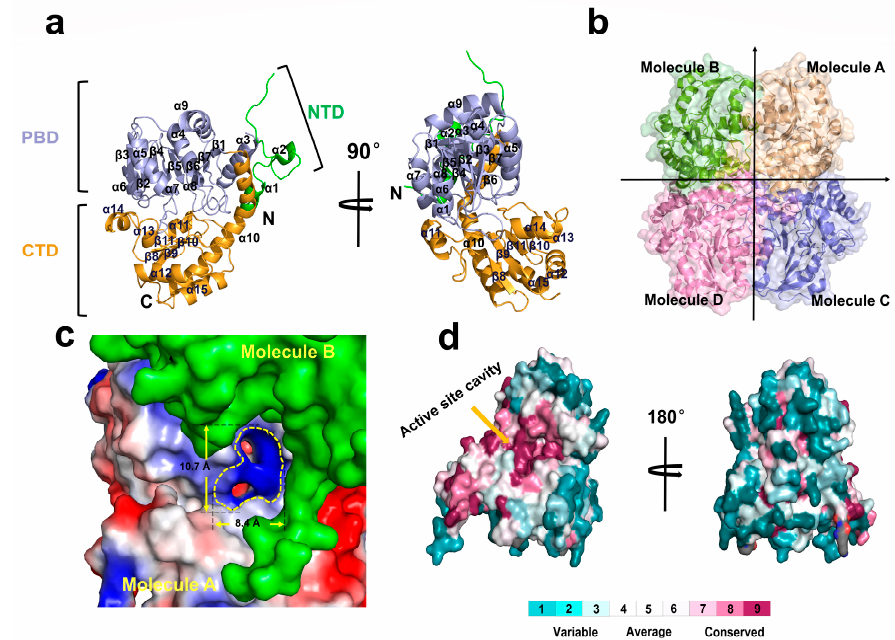
Figure 2. Analysis of the overall structure of Fn1419. ( a ) Monomer structure of Fn1419 consisting of the N-terminal (NTD), pyridoxal-5-phosphate–binding (PBD), and C-terminal (CTD) domains. ( b ) Tetrameric structure of Fn1419. ( c ) Electrostatistic surface of the dimer interface showing the active site. ( d ) Surface conservation of Fn1419 and MGL proteins. The active site showed high conservation, whereas the other regions were not